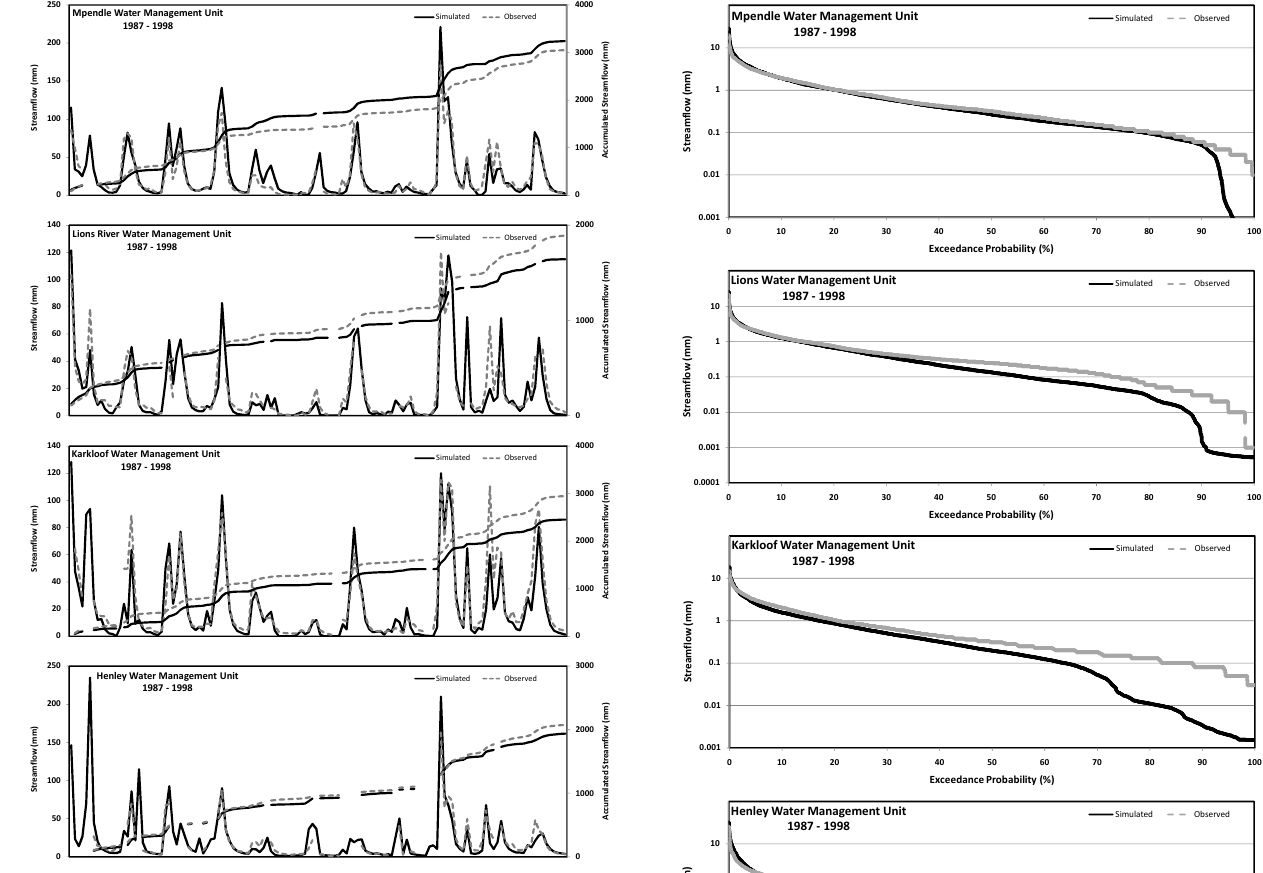
Fig. 7. Comparison of monthly totals of daily simulated and ob- served streamflows for (from top to bottom) the Mpendle WMU, Lions River WMU, Karkloof WMU and the Henley WMU of the Mgeni Catchment.